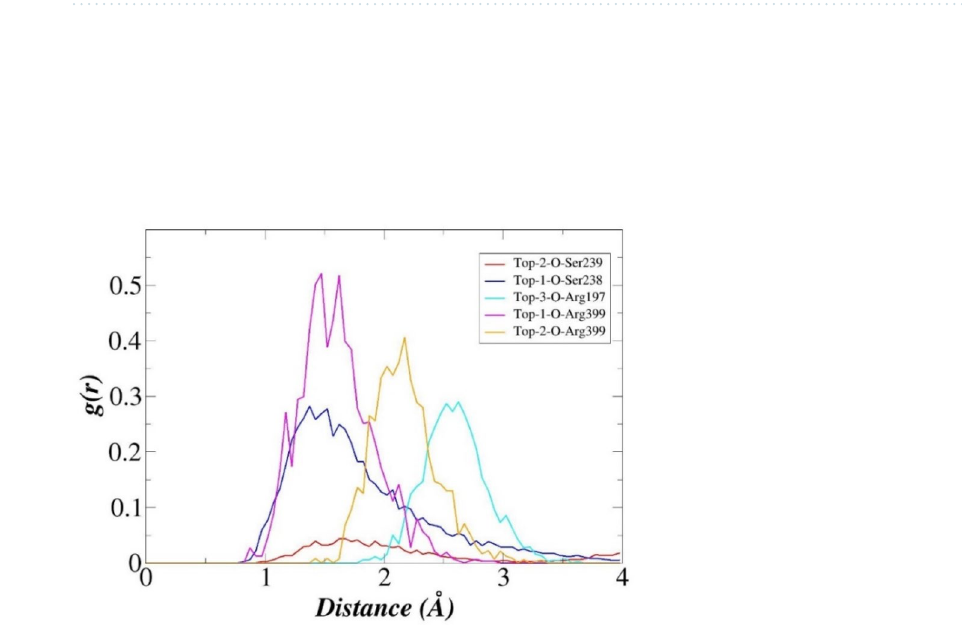
Figure 7. RDF plots of hydrogen bonds between the compounds and enzyme hotspot residues are substantial for engaging the compounds at the docked